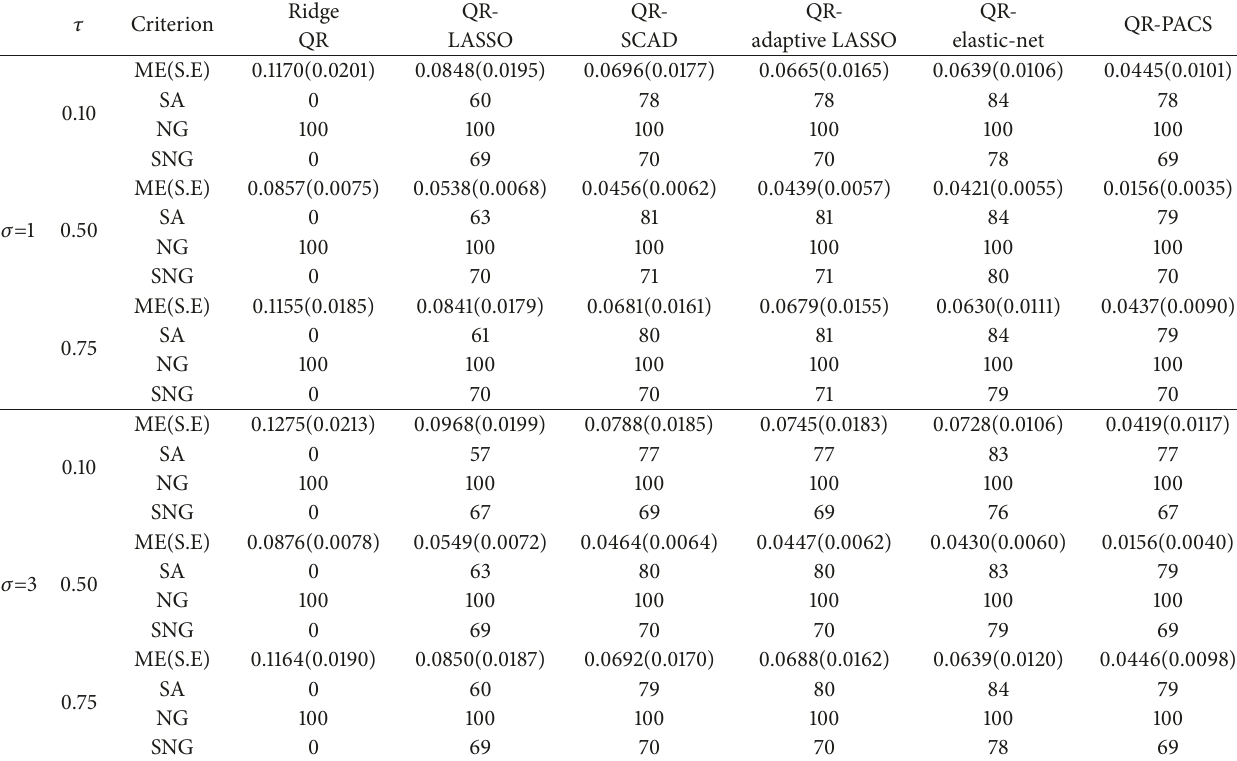
Table 2: ME, SA, GA, and SGA results of Example 2 for